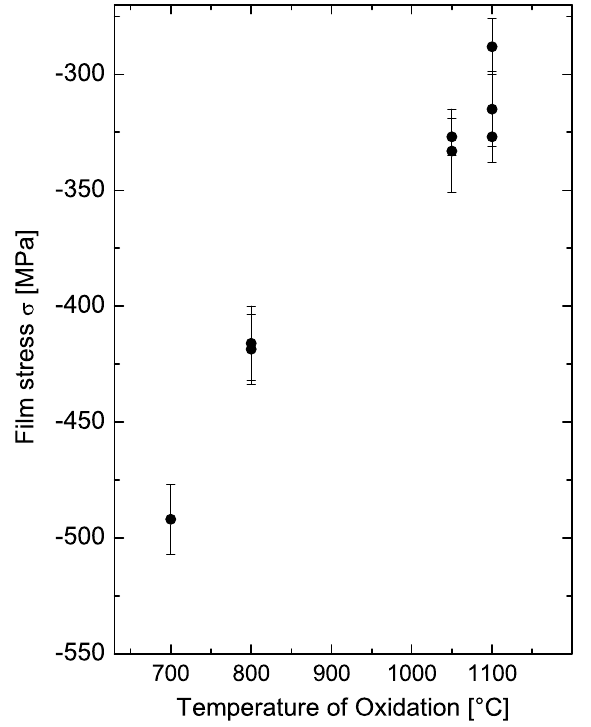
Figure 1. Dependence of silicon oxide film stress on the process temperature. The temperature affects the magnitude of the intrinsic and thermal stress component leading to a variation of the total stress